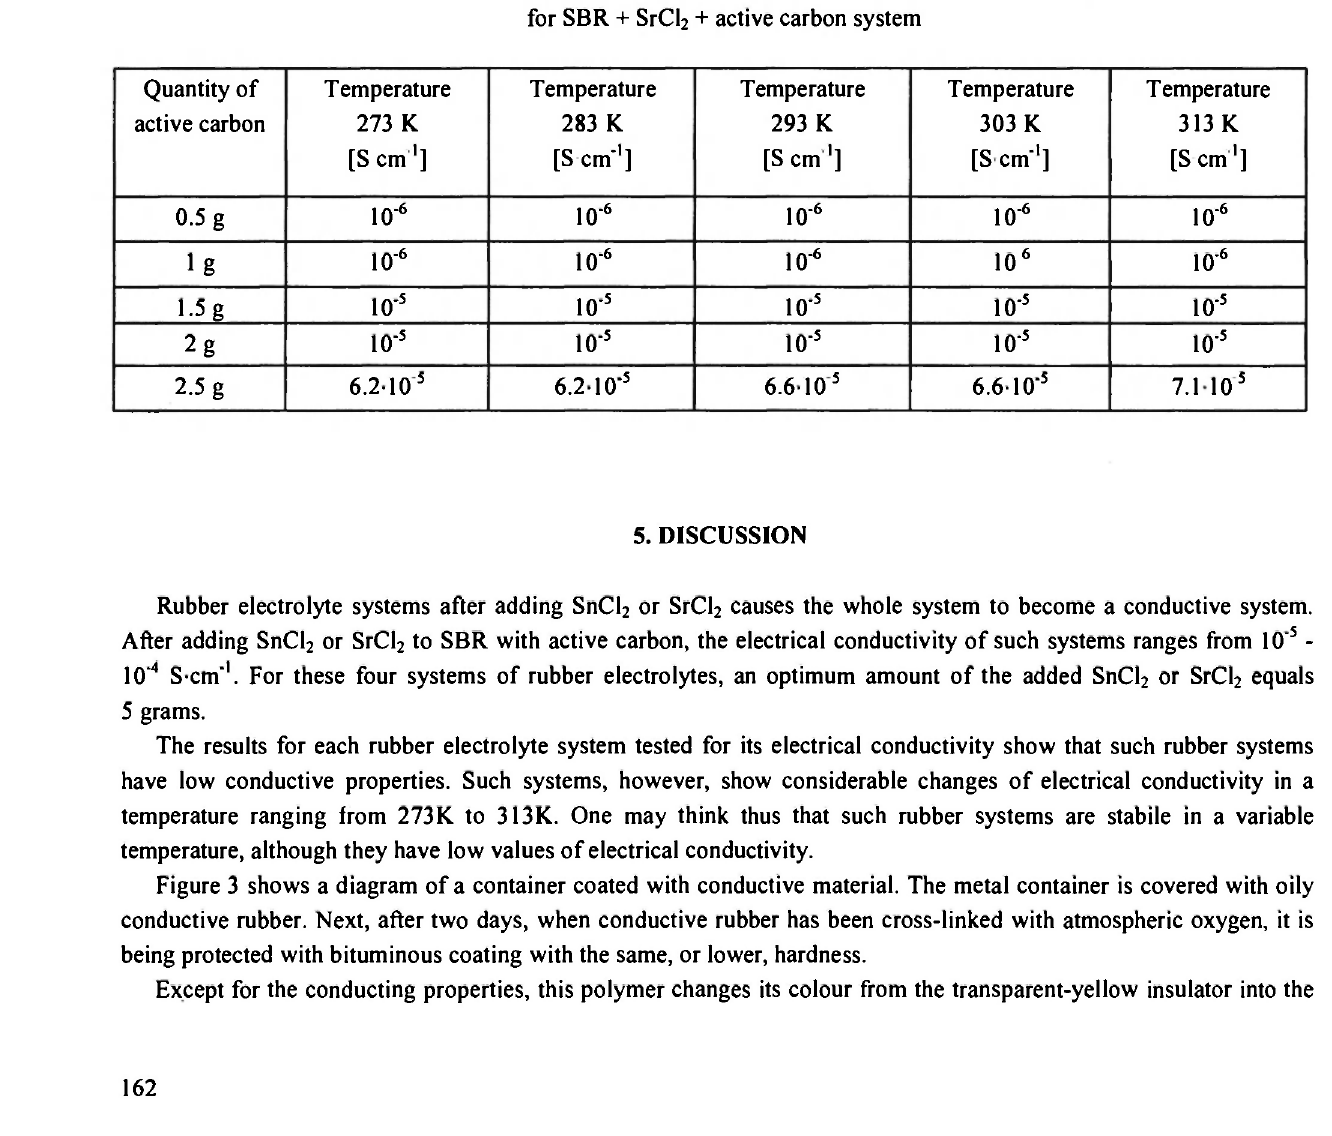
Electrical conductivity of rubber electrolyte in a temperature ranging from 273 Κ to 313